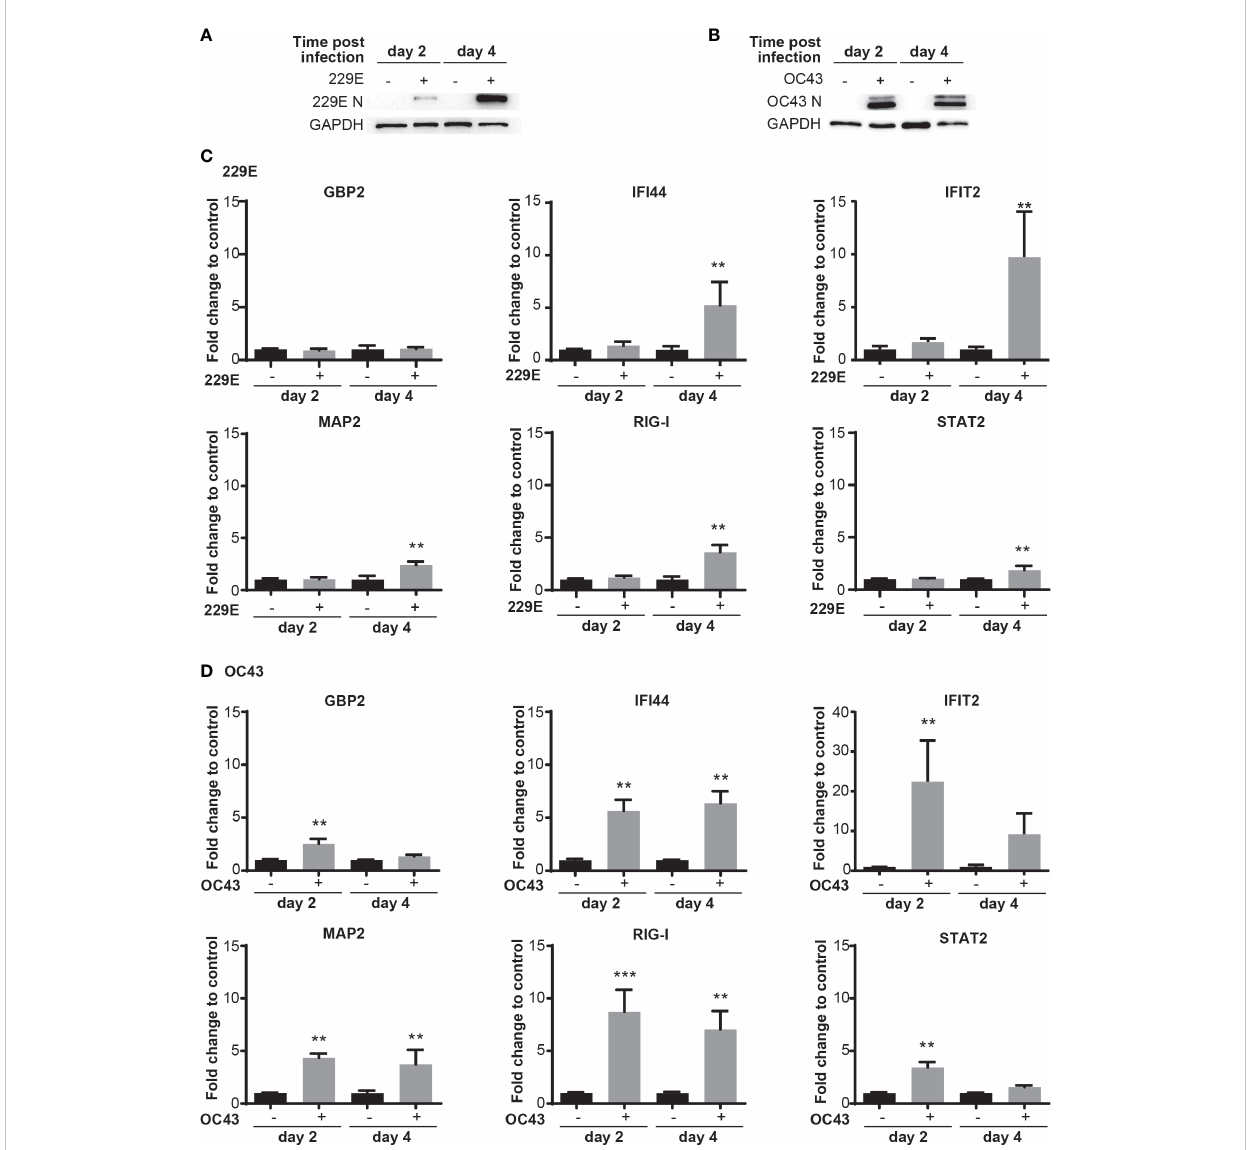
FIGURE 2 Human coronavirus infection activates transcription of IFN-stimulated genes. MRC5 cells were left uninfected or infected with 229E (A, C) or OC43 (B, D) at MOI of 0.01. Infection of 229E (A) and OC43 (B) was con fi rmed by western blot analysis using anti 229E N protein, OC43 N protein and GAPDH antibodies. The mRNA levels of ISGs (GBP2, IFI44, IFIT2, MAP2, RIG-I and STAT2) were determined by RT-qPCR in MRC5 cells infected with 229E (C) or OC43 (D) (n=6). The fold change to control indicates the fold change of the expression level for infected samples towards that of the non-infected controls at the same time point post infection. The transcriptional level for each gene was calculated by normalizing to GAPDH expression level and then normalized by the corresponding control. **p<0.01, ***p<0.001 for RIG-I OC43, Two-way